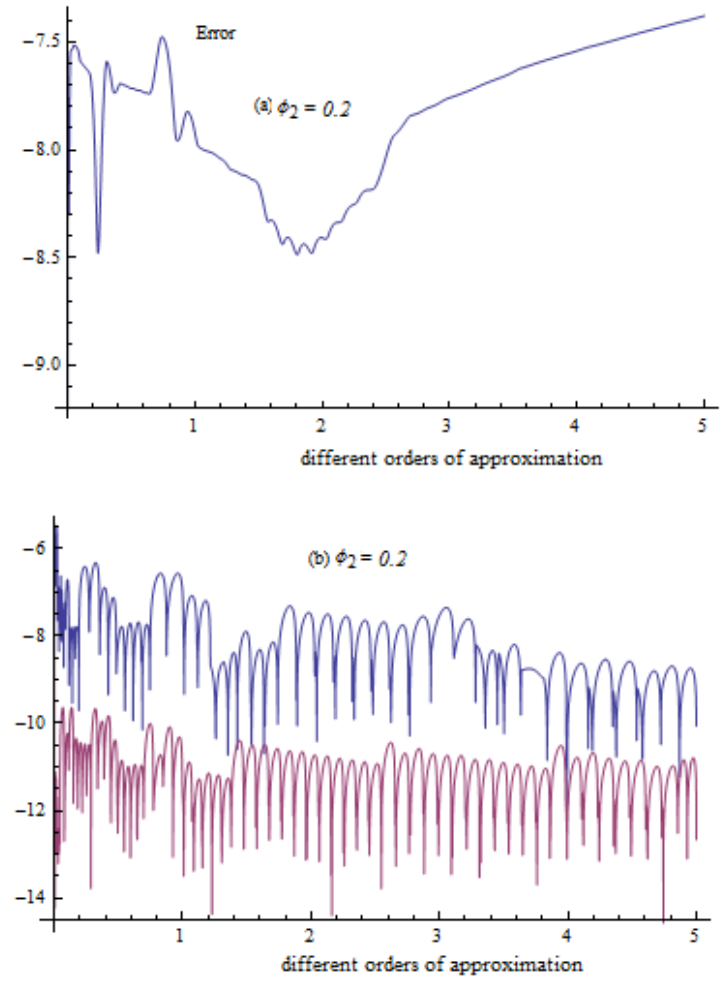
Figure 5. Error ( a ) and residue error ( b ) for φ 2 = 0.2. The blue line represents the average residue error and the red line represent the total average residue error in ( b ).